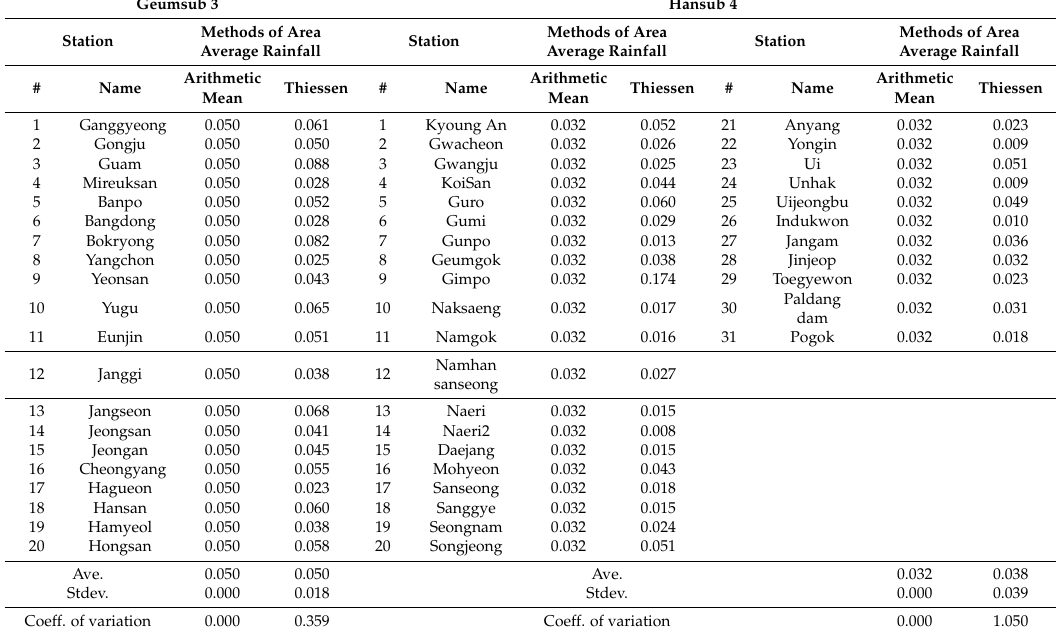
Table 6. Weighting Factor of Each Rain Gauge Station Depending on the Estimation Method of